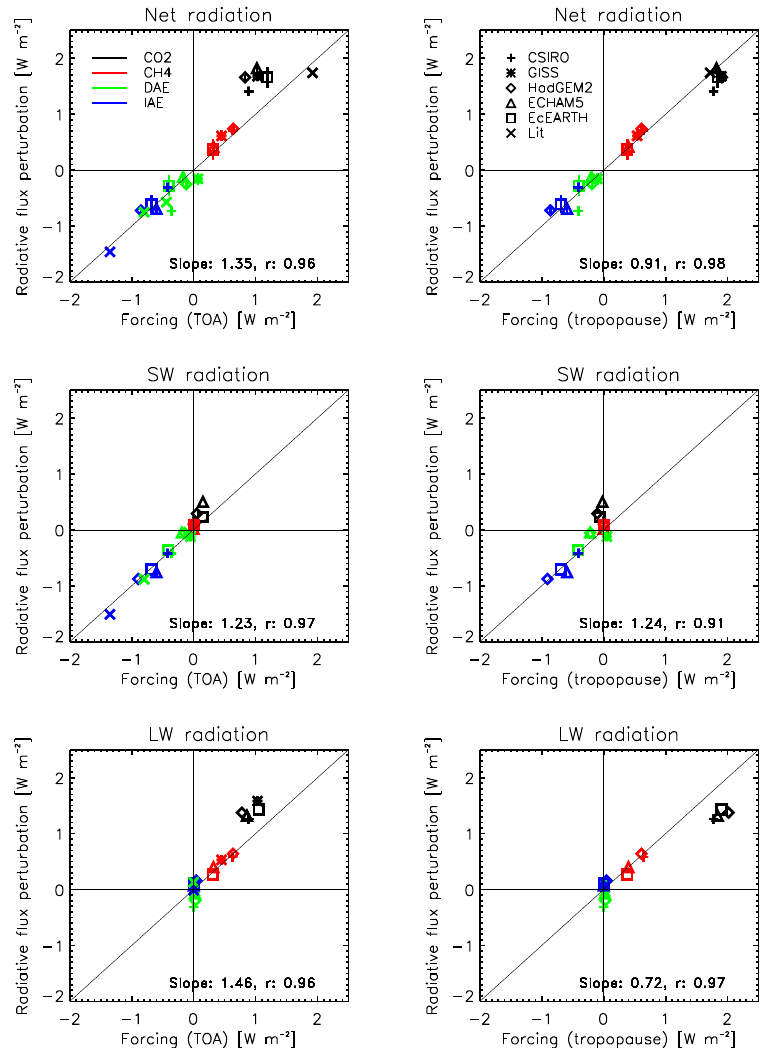
Fig. 2. Net, shortwave and longwave radiative flux perturbation ( RFP ) versus top-of-the-atmosphere (TOA) and tropopause forcing ( F ), respectively, from five GCMs. Vertical bars denote the interannual standard deviation in the radiative flux perturbation calculations. The slope of the least square fit through the data as well as the correlation coefficient r are shown at the bottom. RFP vs. F values from the literature (Rotstayn and Penner, 2001; Hansen et al., 2005) are added as well.